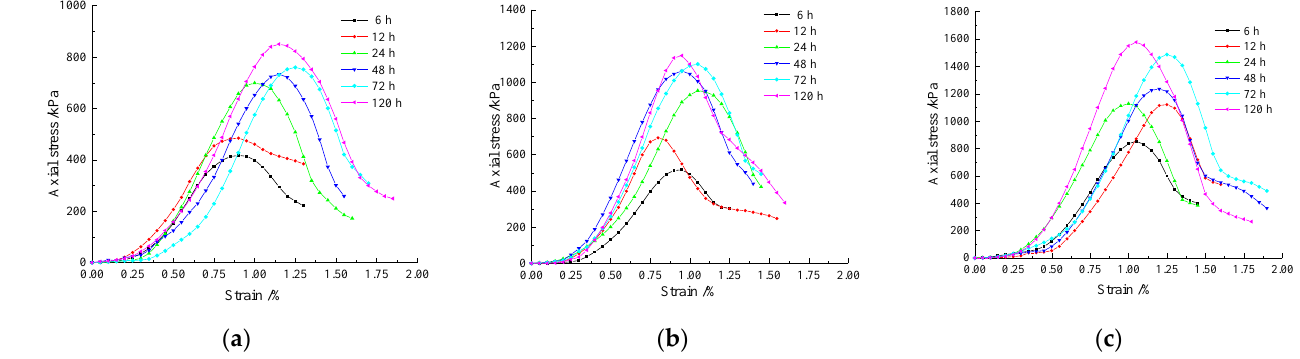
Figure 7. ( a ) Stress – strain curve of the simulated site soil with curing under 5% CO 2 concentration. ( b ) Stress – strain curve of the simulated site soil with curing under 10% CO 2 concentration. ( c ) Stress – strain curve of the simulated site soil with curing under 15% CO 2 concentration.